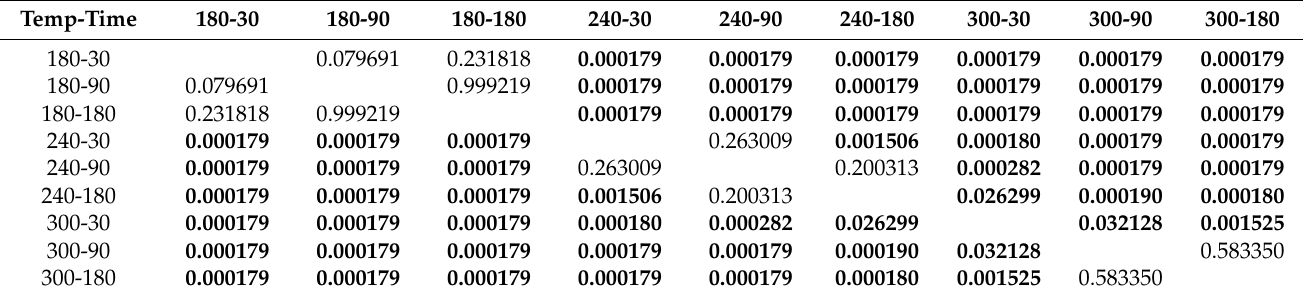
Table A4. Two-way analysis of variance (ANOVA) with post hoc Tukey test for HHV , a bold font signifies a statistically significant difference ( p < 0.05).